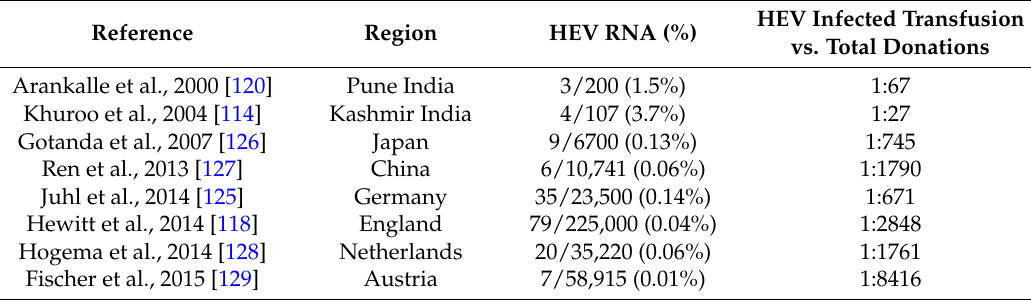
Table 2. HEV RNA in blood donors.